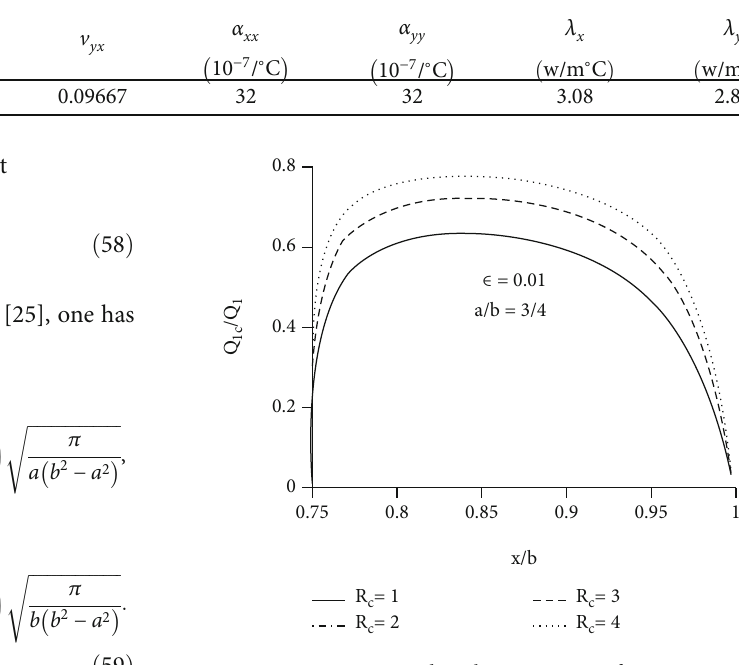
= 1, 2, 3, 4 for ε =0.01 and a / c